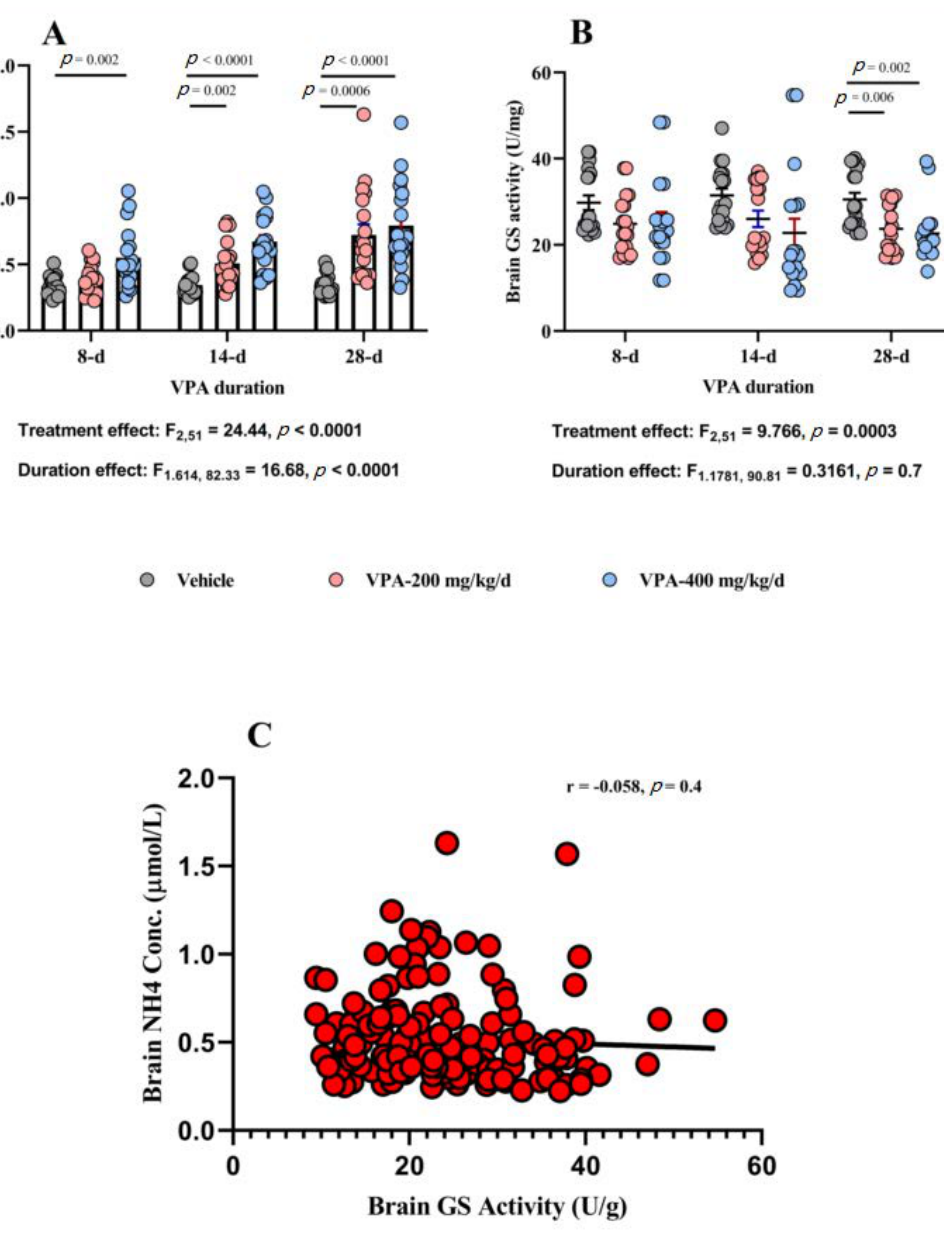
Figure 3. The e ff ect of VPA on brain ammonia (NH 4 ) concentration and glutamine synthetase (GS) enzyme activity. ( A ) VPA treatment (F 2,51 = 24.44, p < 0.0001) and duration (F 1.614,82.33 = 16.68, p < 0.0001) both show significant e ff ects on brain NH 4 concentration by two-way ANOVA ( n = 6 / group). Significant di ff erences in brain NH 4 concentrations were observed at tested time points between vehicle and both VPA doses. Vehicle vs. VPA 200 mg / kg / d at 14 d (mean di ff erence, 95% CI, p value: − 0.1630, − 0.2698 to − 0.05617, p = 0.002) and at 28 d (mean di ff erence, 95% CI, p value: − 0.3726, − 0.5811 to − 0.1641, p = 0.0006). Vehicle vs. VPA 400 mg / kg / d at 8 d (mean di ff erence, 95% CI, p value: − 0.2159, − 0.3543 to − 0.07754, p = 0.02) and at 14 d (mean di ff erence, 95% CI, p value: − 0.3281, − 0.4579 to − 0.1983, p < 0.0001) and at 28 d (mean di ff erence, 95% CI, p value: − 0.4423, − 0.6428 to − 0.2419, p < 0.0001) by Tukey’s multiple comparisons test. ( B ) VPA treatment has significant e ff ect on brain GS activity: F 2,51 = 9.766, p = 0.0003 by two-way ANOVA ( n = 6 / group). Significant di ff erences were observed only at 28 d of treatment between vehicle and VPA 200 mg / kg / d (mean di ff erence, 95% CI, p value: 6.803, 1.772 to 11.83, p = 0.006) and between vehicle and VPA 400 mg / kg / d (mean di ff erence, 95% CI, p value: 7.899, 2.573 to 13.23, p = 0.002) by Tukey’s multiple comparisons test. ( C ) No significant correlation was found between brain NH 4 concentration and brain GS activity: r = − 0.058, p =